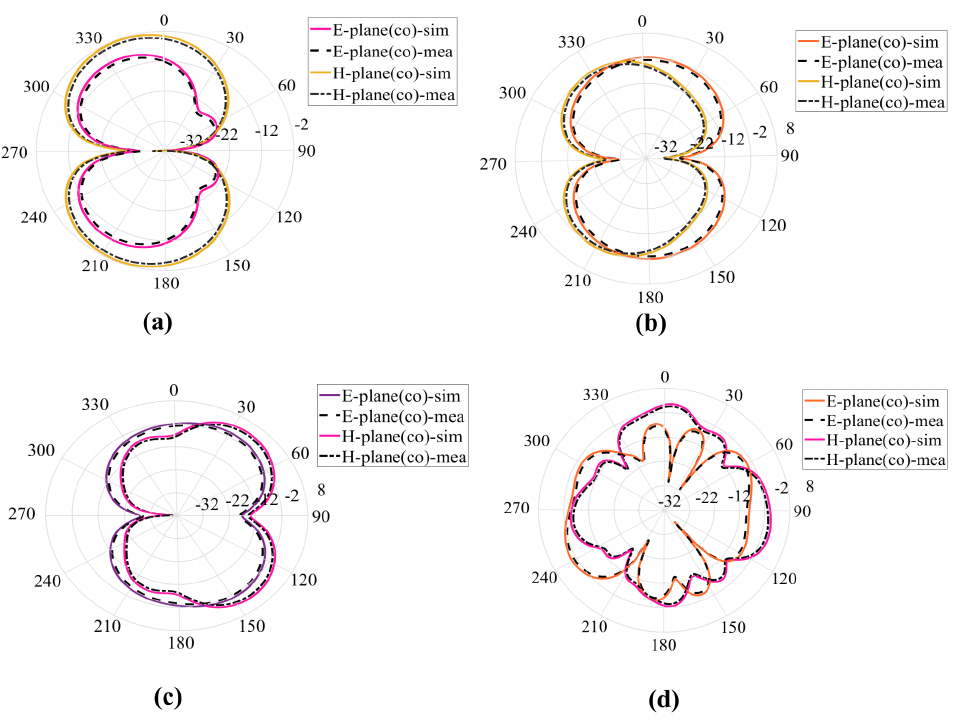
Figure 10. E-H plane radiation patterns for Co-polarization for different frequencies ( a ) 2.5 GHz ( b ) 3.5 GHz ( c ) 6.5 GHz ( d ) 17 GHz.